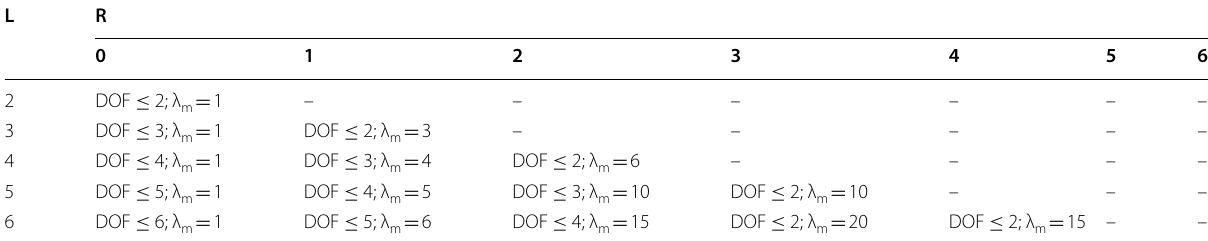
Table 1 Degree of freedom, kinematic chain number, and the degree of configurable operation (λ